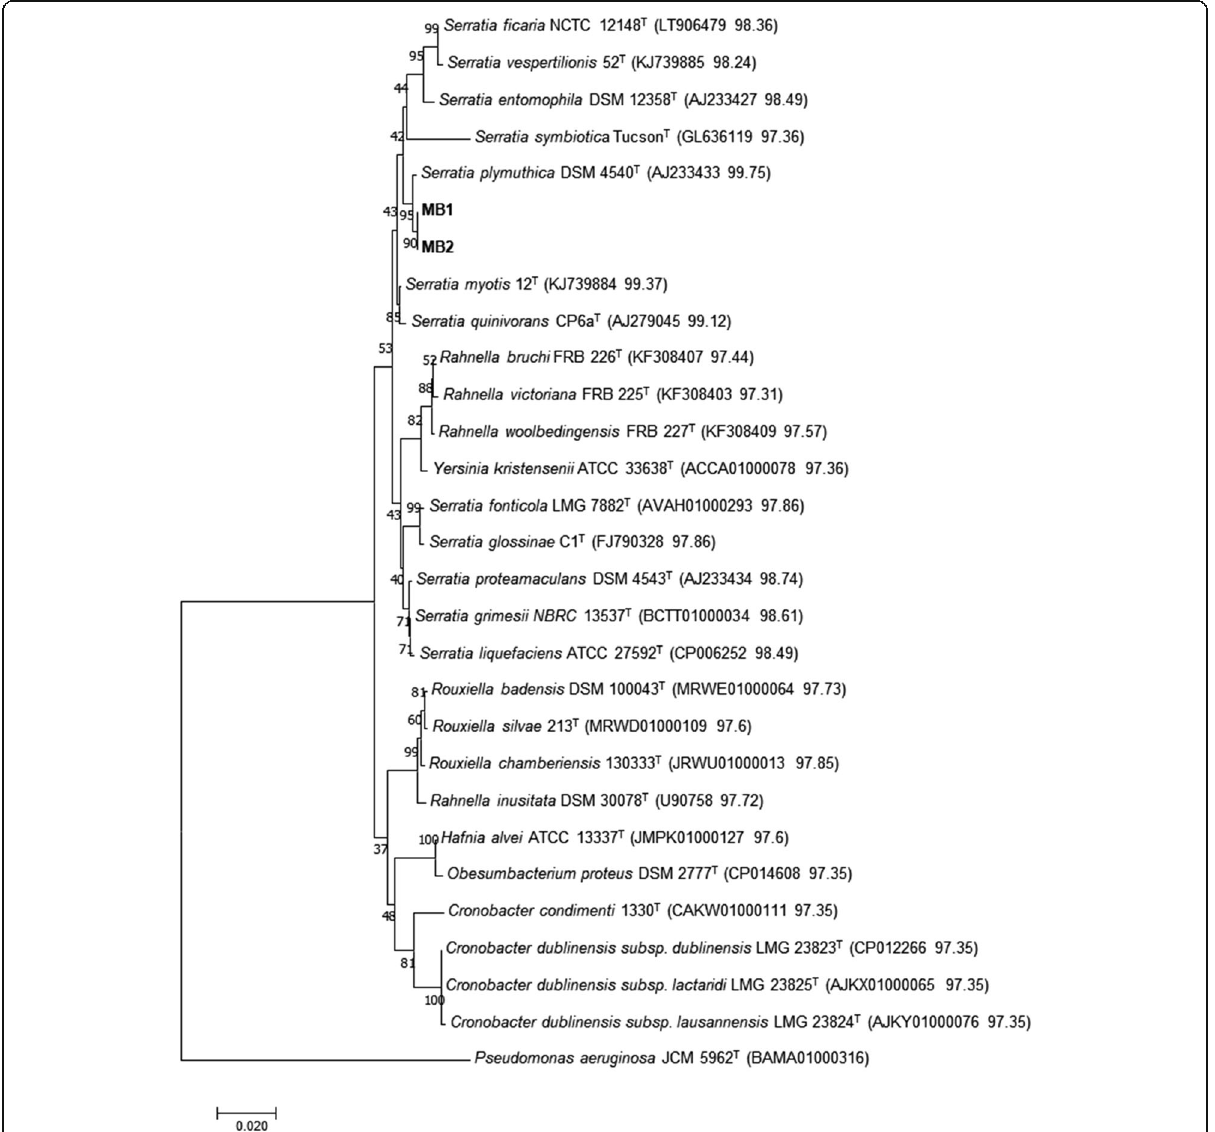
Fig. 1 Phylogenetic tree of Serratia plymuthica strains MB1 and MB2 derived from similarities in the 16S rDNA sequence. Bootstrap percentages of 80% or more are indicated at the branching points. S. plymuthica DSM 4540T (AJ233433) was used as the root